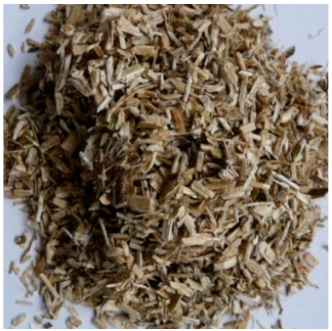
Figure 1. View of technical hemp hurd slices.